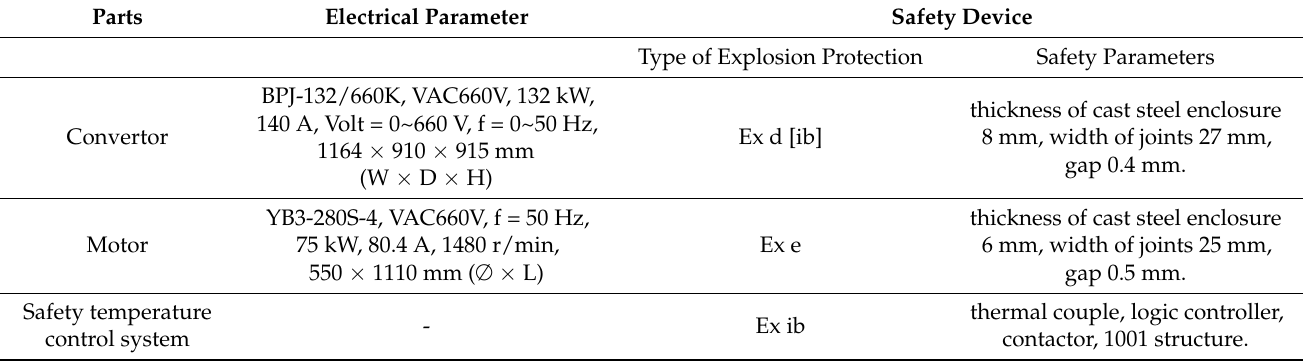
Table 11. Hardware configuration of a mining VFD system for a belt